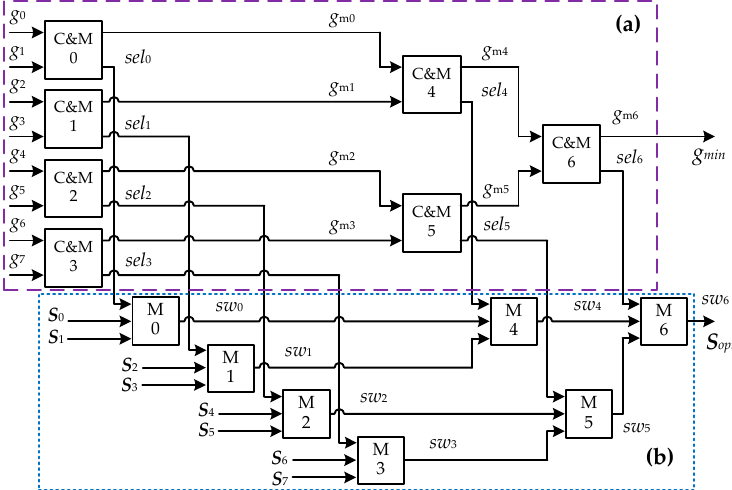
Figure 4. Block diagram to represent logic for the ( a ) selection of minimum of cost function, and ( b ) selection of optimum switching state.